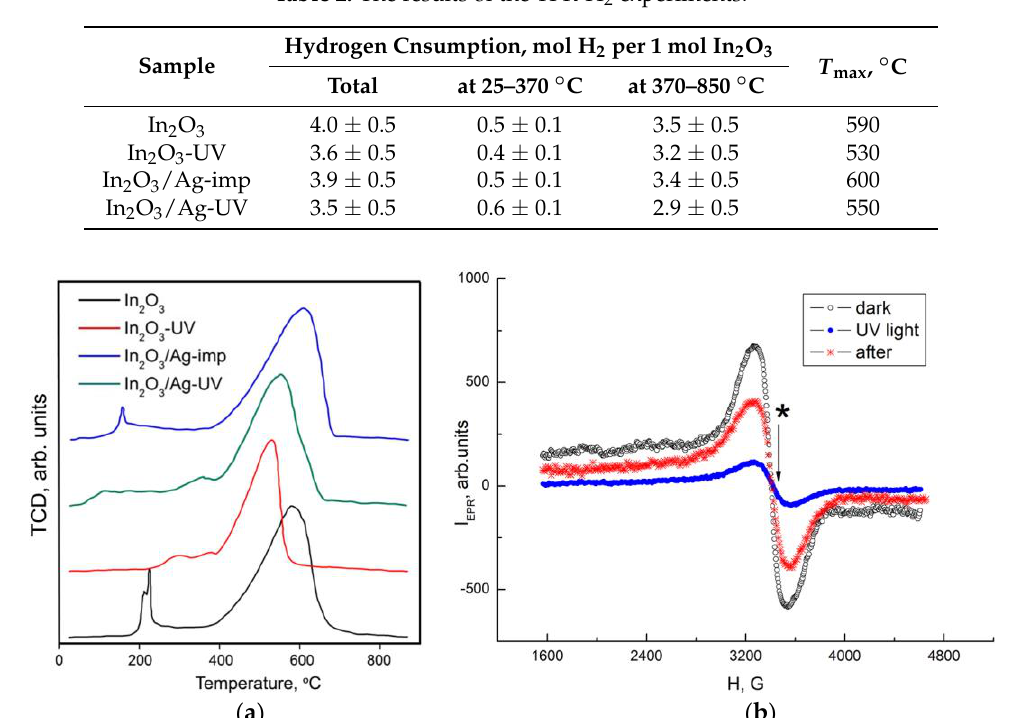
Figure 9. ( a ) TPR-H 2 profiles of In 2 O 3 and In 2 O 3 /Ag nanocomposites; ( b ) EPR spectra of In 2 O 3 -UV sample in dark conditions, under UV illumination and in 20 min after that.